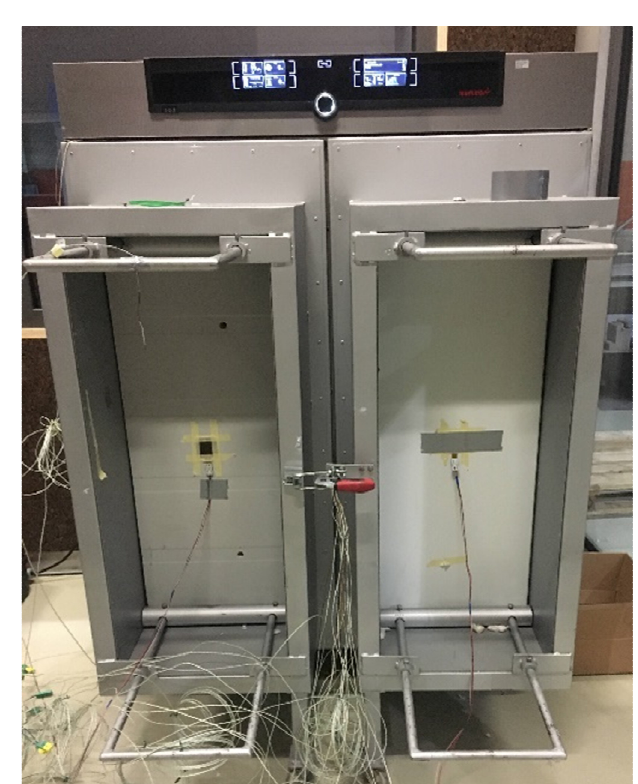
Figure 4. Photographic register of the oven door modifications.